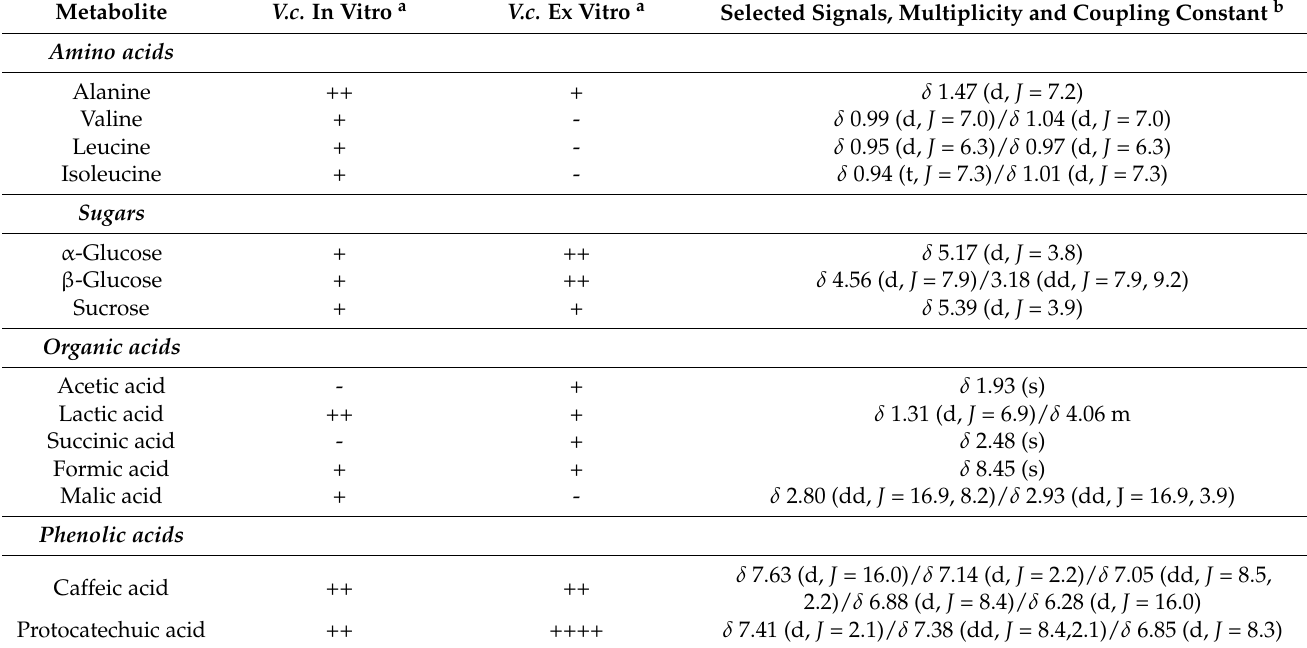
Table 2. Chemical shifts ( δ ) and coupling constants ( J ) of the metabolites identified in V. caucasica plants by their relevant 1D and 2D NMR spectra.